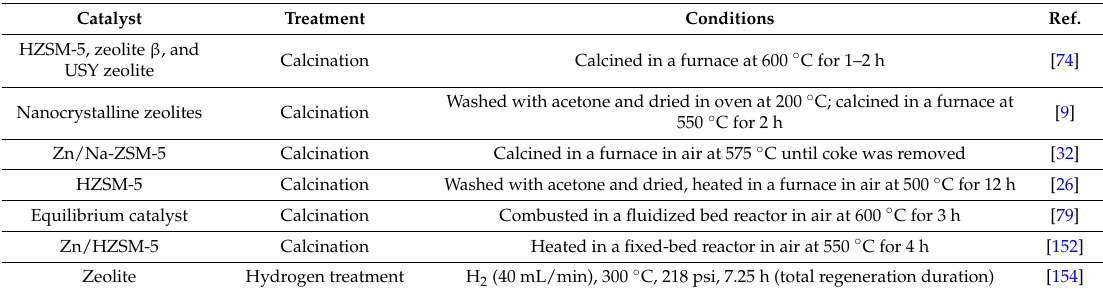
Table 11. The common catalyst regeneration